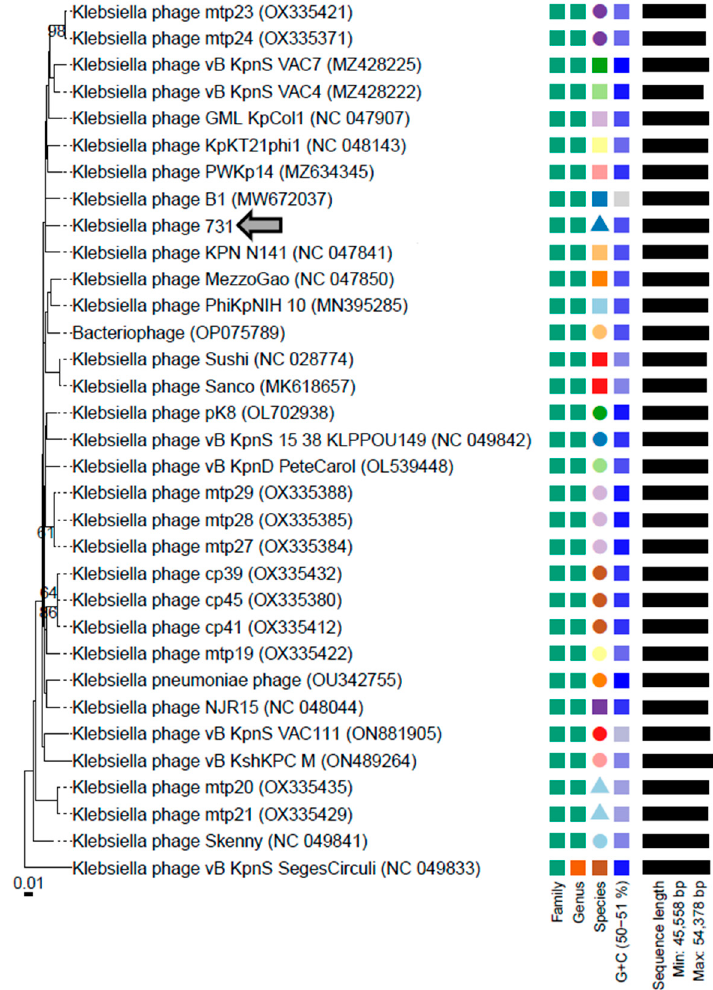
Figure 3. Whole genome-based phylogenetic relations of phage 731. Genome–BLAST distance phylogeny (GBDP) trees were inferred using the formula D4 and yielded average support of 17%. The numbers above branches are GBDP pseudo-bootstrap support values from 100 replications. The branch lengths of the resulting VICTOR trees are scaled in terms of the respective distance formula used. The OPTSIL clustering yielded 26 species clusters, 2 clusters at the genus level, and 1 at the family level. Accession numbers are also indicated next to the phage names. Klebsiella phage 731 is marked with a grey arrow ( ).